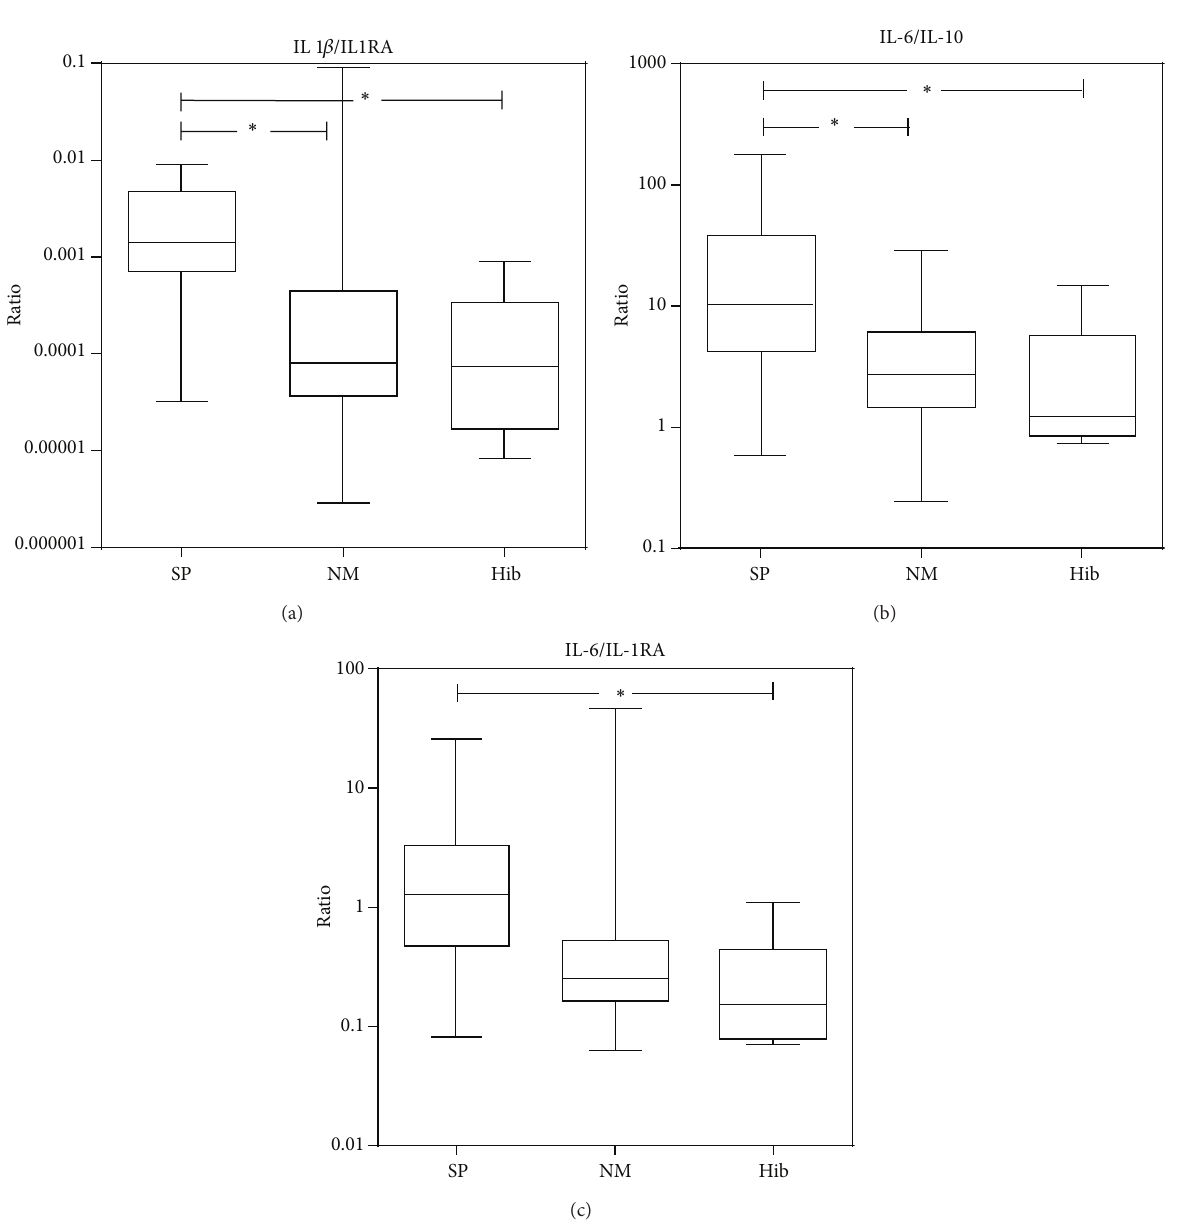
Figure 3: Ratio of pro- to anti-inflammatory mediators. Statistically significant differences ( ∗ 𝑃 < 0.05 ) in the ratios of IL-1 𝛽 /IL-1RA, IL- 6/IL-10, and IL-6/IL-1RA were observed in patients with BM grouped for the causative